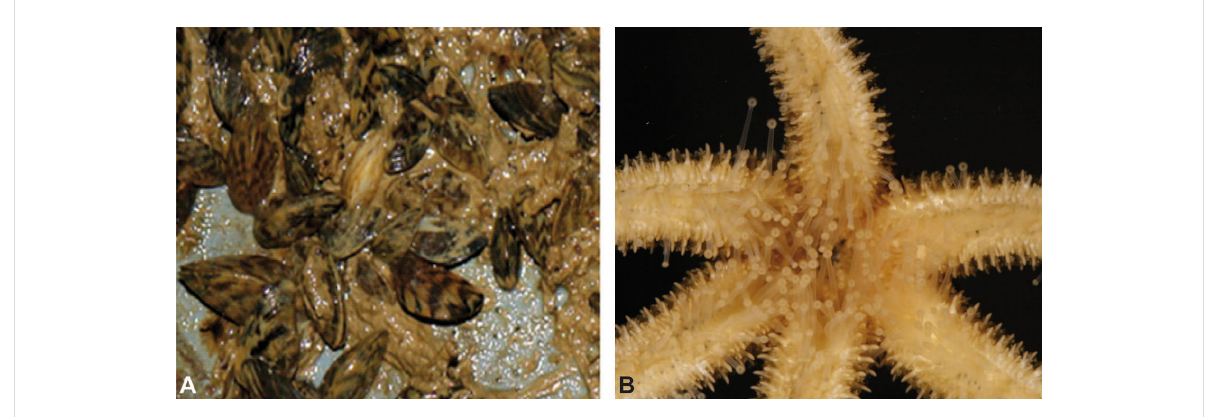
Figure 5: A) Zebra mussles attaching by byssal threads to a substrate, B) echinoderm foot (images: Petra Ditsche).